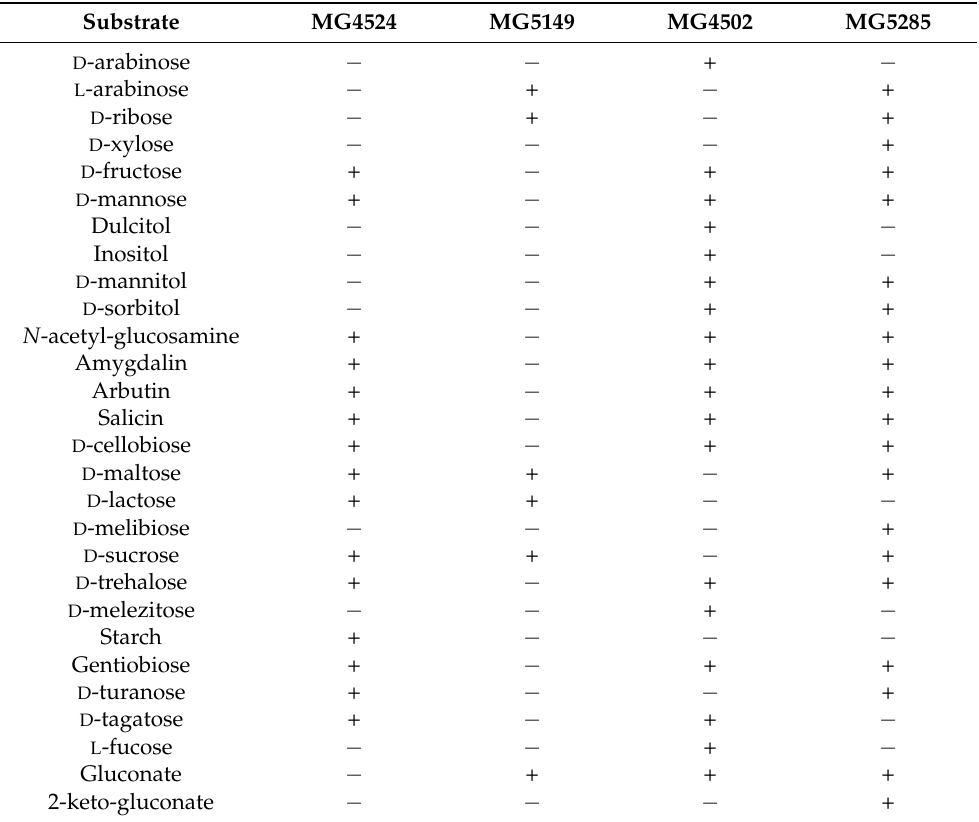
Table 4. Summary of the carbohydrate fermentation profiles of the selected probiotic candidate strains as measured using the API 50 CHL